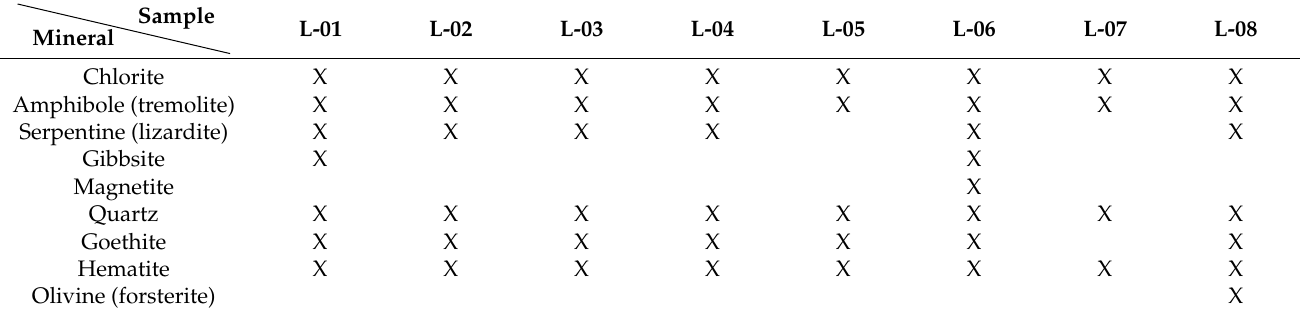
Table 5. Results of the X-ray diffraction